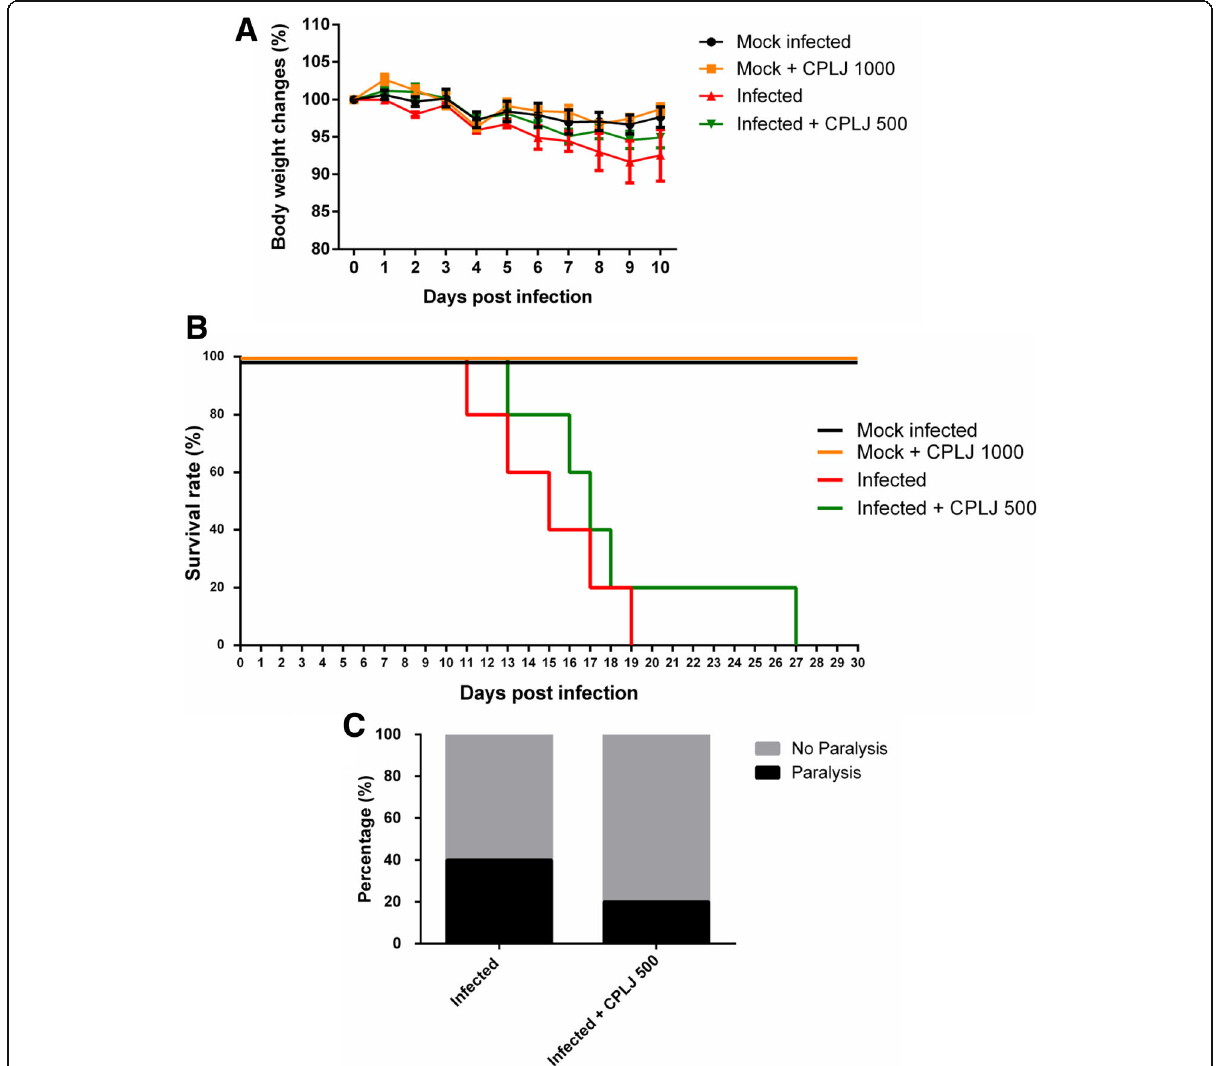
Fig. 4 The freeze-dried C. papaya leaves juice slightly affecting the morbidity development of AG129 mice infected with 2 X 10 6 PFU dengue virus. a Body weight changes of mock infected (black lines) ( n =5), infected (red lines) ( n =5) and infected+CPLJ (green lines) ( n =5) AG129 mice groups were monitored daily. Data represent mean values ± standard error of the mean (SEM). b Number of moribund AG129 mice in mock infected (black lines) ( n =5), mock+CPLJ 1000 (orange line) ( n =5), infected (red lines) ( n =5) and infected+CPLJ 500 (green lines) (n=5) groups were recorded daily for 30 days post infection. Kaplan-Meier curves illustrated the susceptibility of AG129 mice to dengue virus. Percentage of survival between experimental groups were compared using Log-rank (Mantel-Cox) test. However, the survival differences were not statistically significant between infected and infected+CPLJ 500 groups. c The number of mice developing paralysis (complete paralysis of one or both hindlimbs) were recorded for 30 days post infection. Data represent percentages of total moribund AG129 mice with and without sign of